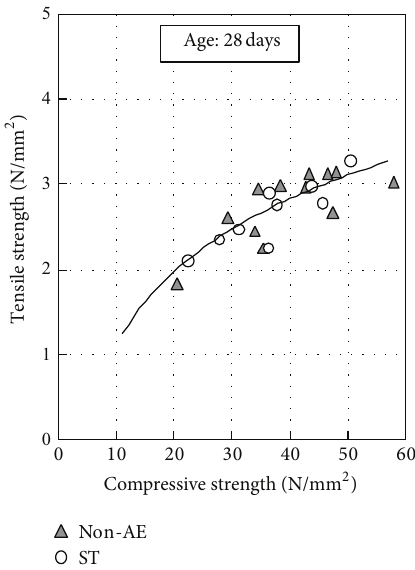
Figure 3: Relationship between compressive strength and tensile